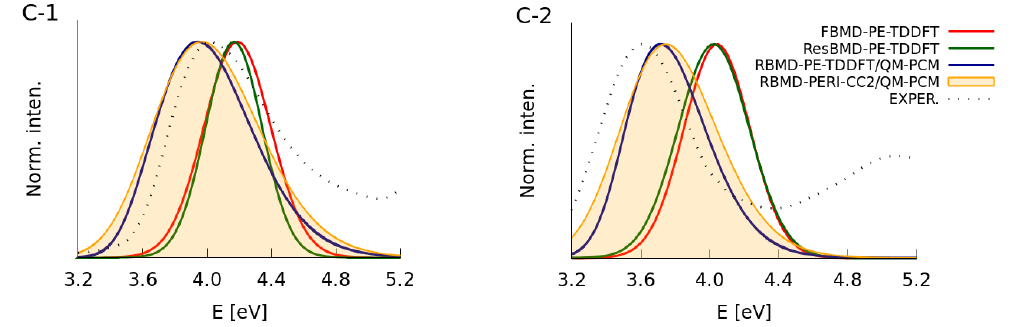
Figure 7. The comparison of the experimental spectra for the C-1 and C-2 molecules with the results of simulations employing nonempirical broadenings.